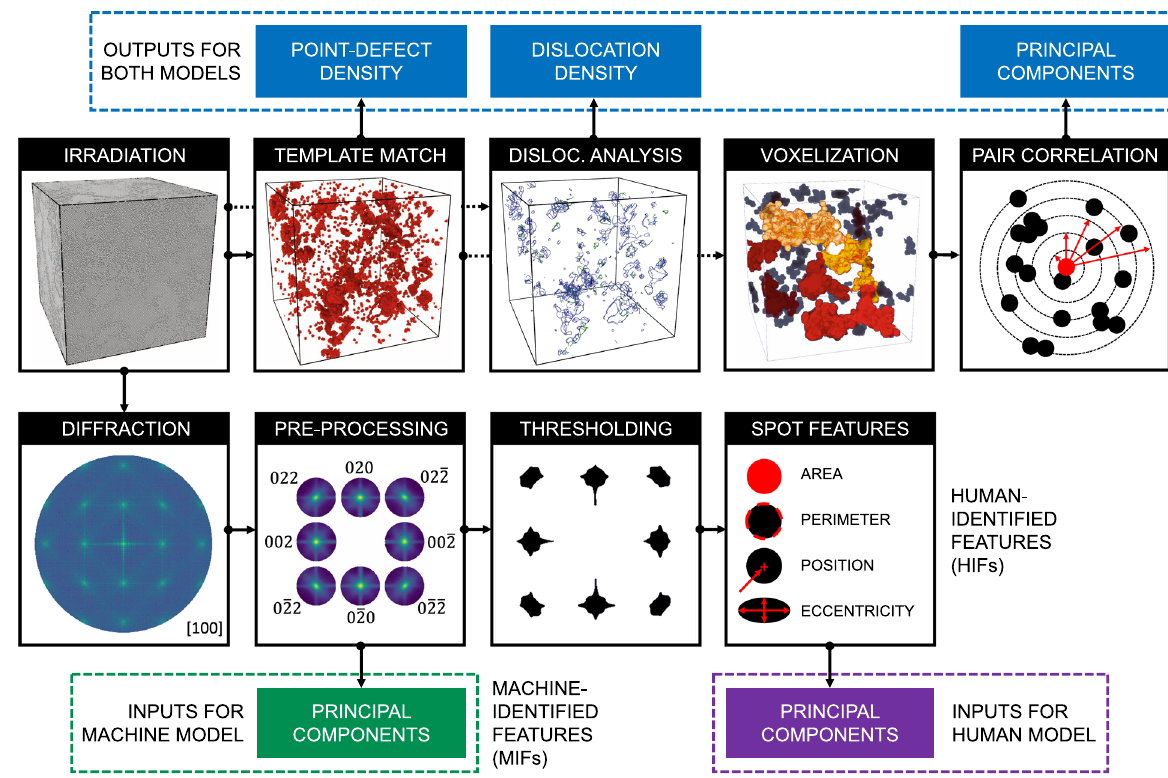
Fig. 1 Overview of the process for producing the inputs (i.e. SAED features) and the outputs (i.e. defect statistics) for the two machine- learning models (i.e. the human model and the machine model). Atomistic representations visualized via OVITO 63 . SAED pattern visualized via ParaView 64